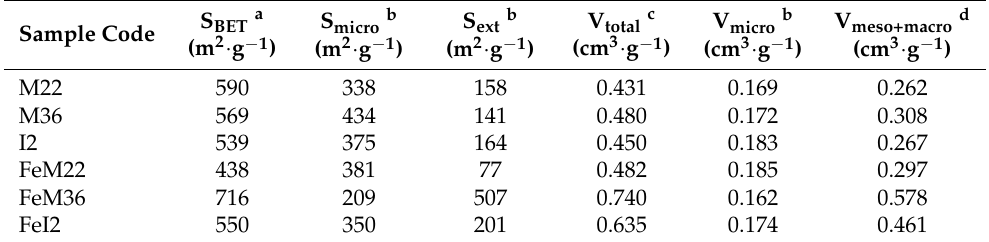
Table 2. Textural and structural properties of the samples recognized from N 2 sorption